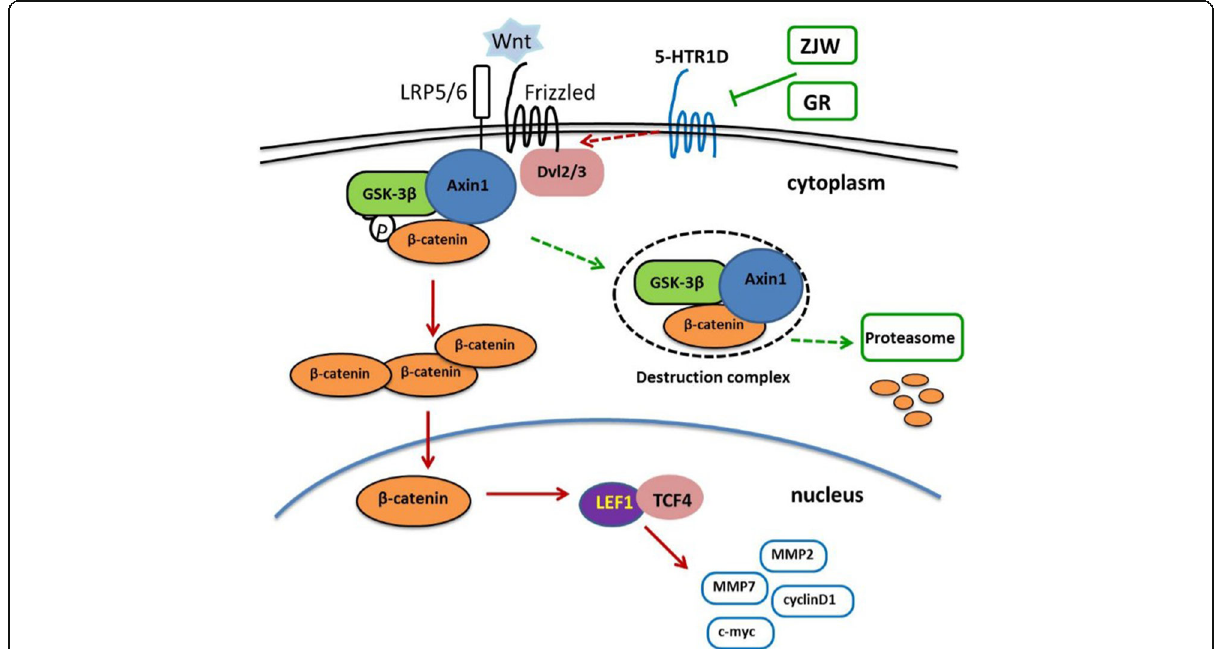
Fig. 6 A schematic model for ZJW extracts in inhibiting 5-HTR1D and attenuating Wnt/ β -catenin signaling pathway. Wnt/ β -catenin signaling is activated by the binding of Wnt ligand to Frizzled receptor and LRP5/6 co-receptors, leading to the recruitment of Dvl and destruction complex to the membrane, which inactivates destruction complex, causing accumulated β -catenin to enter nucleus and activate target gene transcription (red arrows). 5-HTR1D may play a role in promoting the Wnt/ β -catenin signaling at upper stream, leading to stabilization of β -catenin (red arrows). The effect of ZJW extracts on Wnt/ β -catenin resembles that of GR127935 (GR), an antagonist of 5-HTR1D, in inhibiting (green arrows) the Wnt/ β - catenin signaling through enhanced β -catenin degradation, thus prohibiting the signaling